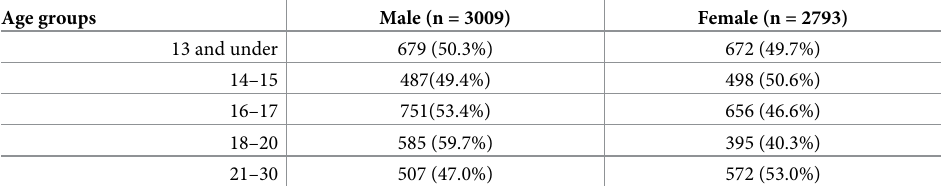
Table 1. Number of competition results stratified by sex and age. Youth competition age categories are below 18, Juniors are ages 15–20, and Seniors ages 15 and older. Age